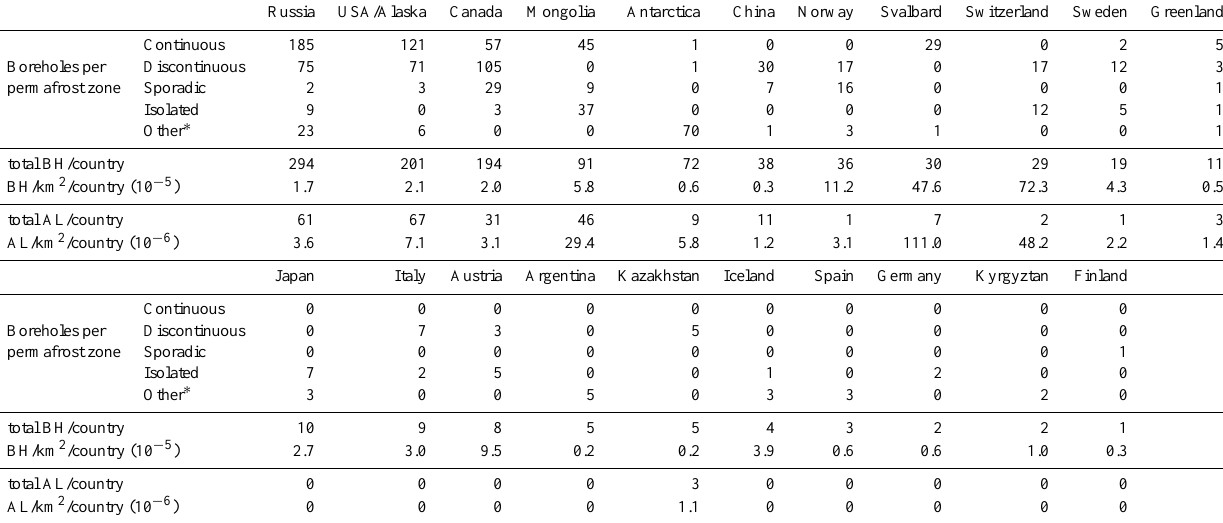
Table 1. Borehole (BH) and active layer (AL) monitoring site distribution in the GTN-P